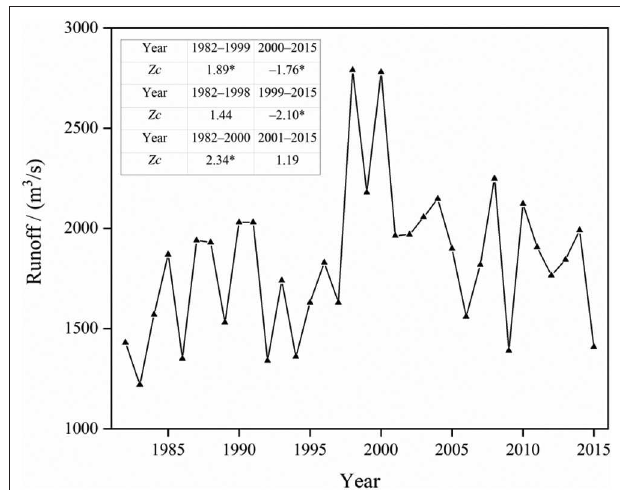
FIGURE 3 | Variation trend of runoff at the Nuxia hydrological station from 1982 to 2015 (*a statistically significant variation trend at the confidence level of